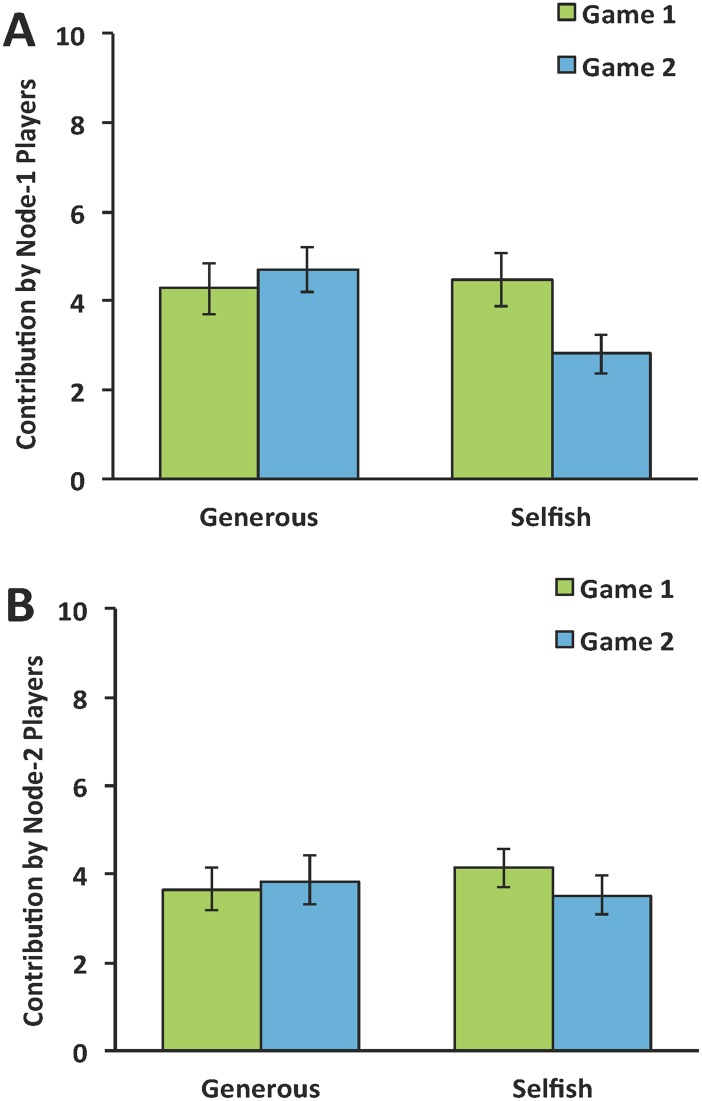
Contributions in Game 1 and Game 2 in Selfish and Generous conditions.(A) Contributions by Node-1 players. In Game 2, participants in the Selfish chain contributed significantly less than those in the Generous chain. Furthermore, participants in the Selfish chain contributed significantly less in Game 2 (after interacting with the selfish Seed Node) than in Game 1. (B) Contributions by Node-2 players. No effects were observed.